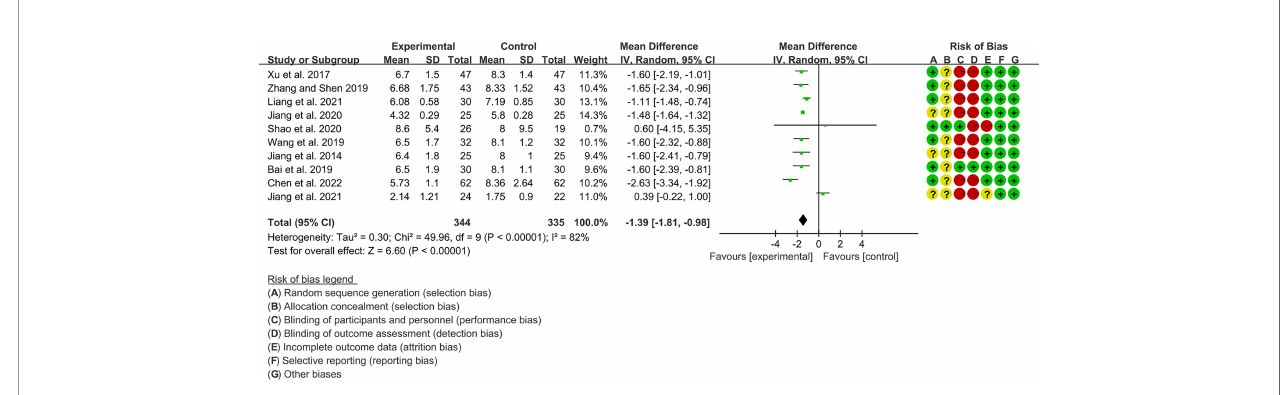
FIGURE 5 | The results of